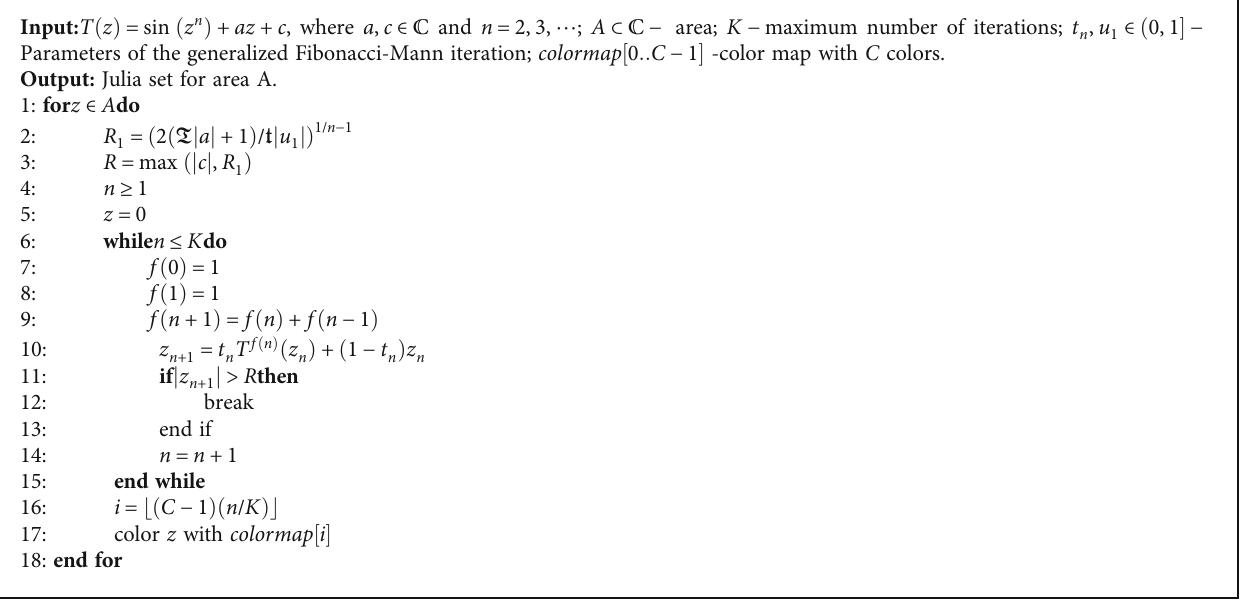
Algorithm 1:Geometry of Julia set.